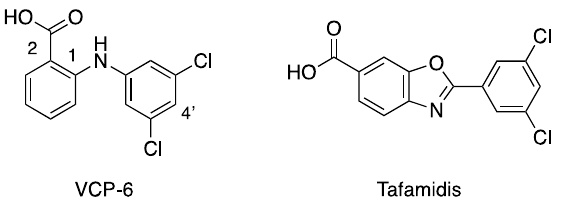
Figure 2. Structures of VCP-6 and tafamidis.